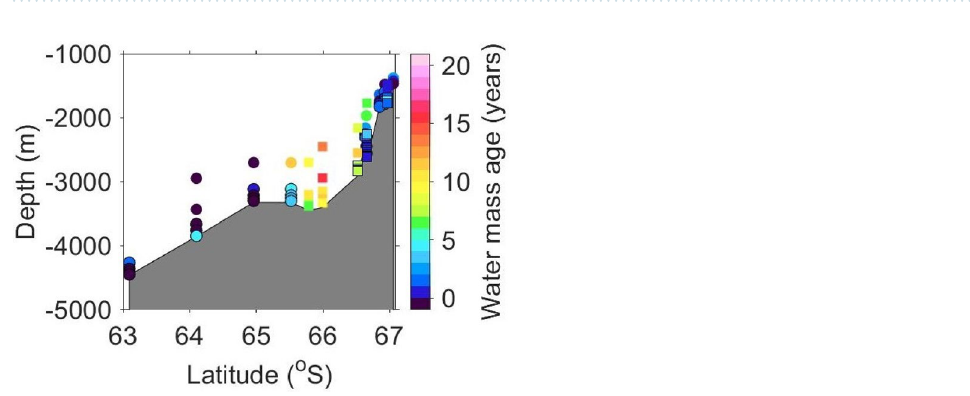
Figure 7. Relationship between potential temperature and water mass age of bottom AABW (neutral density: γ n > 28.27 kg m −3 ) (mean of observations within 100 m of the bottom). The data used are the same as in Fig. 6. The colors denote ( a ) longitude and ( b ) silicate concentration.